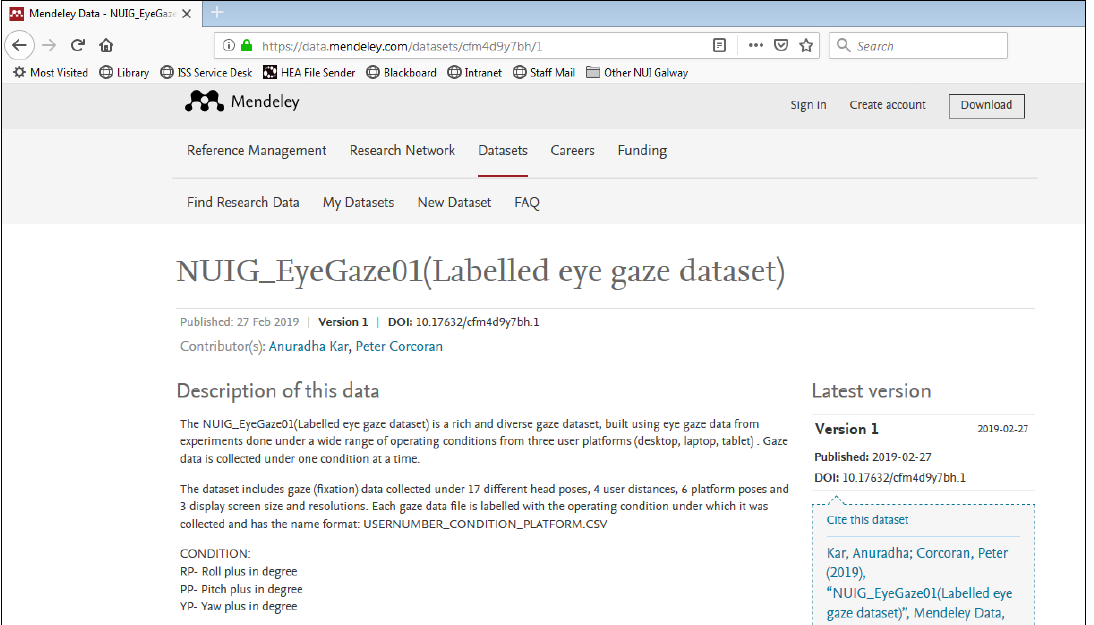
Figure 14. Snapshot of the NUIG_EyeGaze01 repository on Mendeley data.